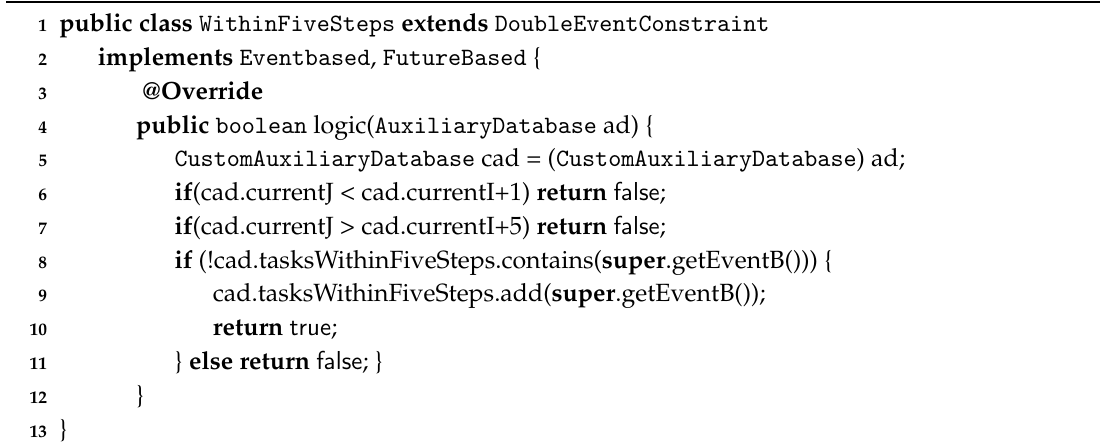
Algorithm 4: Custom constraint WithinFiveSteps.